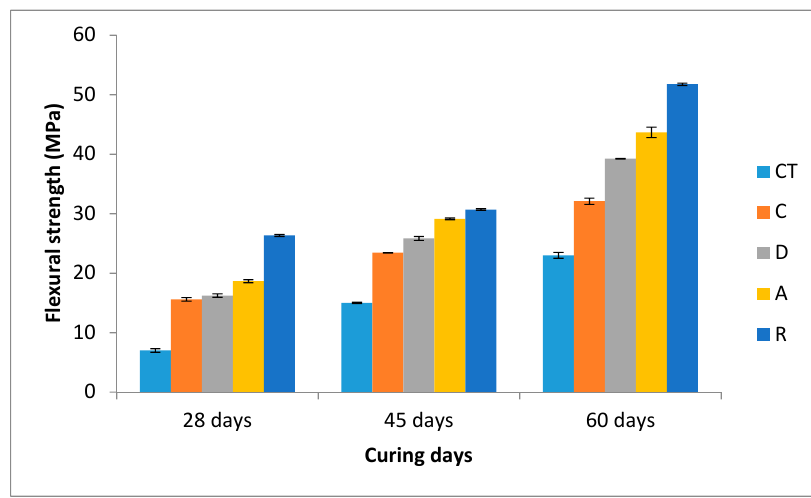
Figure 5. Flexural strength result. Legend: CT = control, C = 10% latex, D = 0.5% fiber and 10% latex, A = 1% fiber and 10% latex and R = 1.5% fiber and 10% latex.